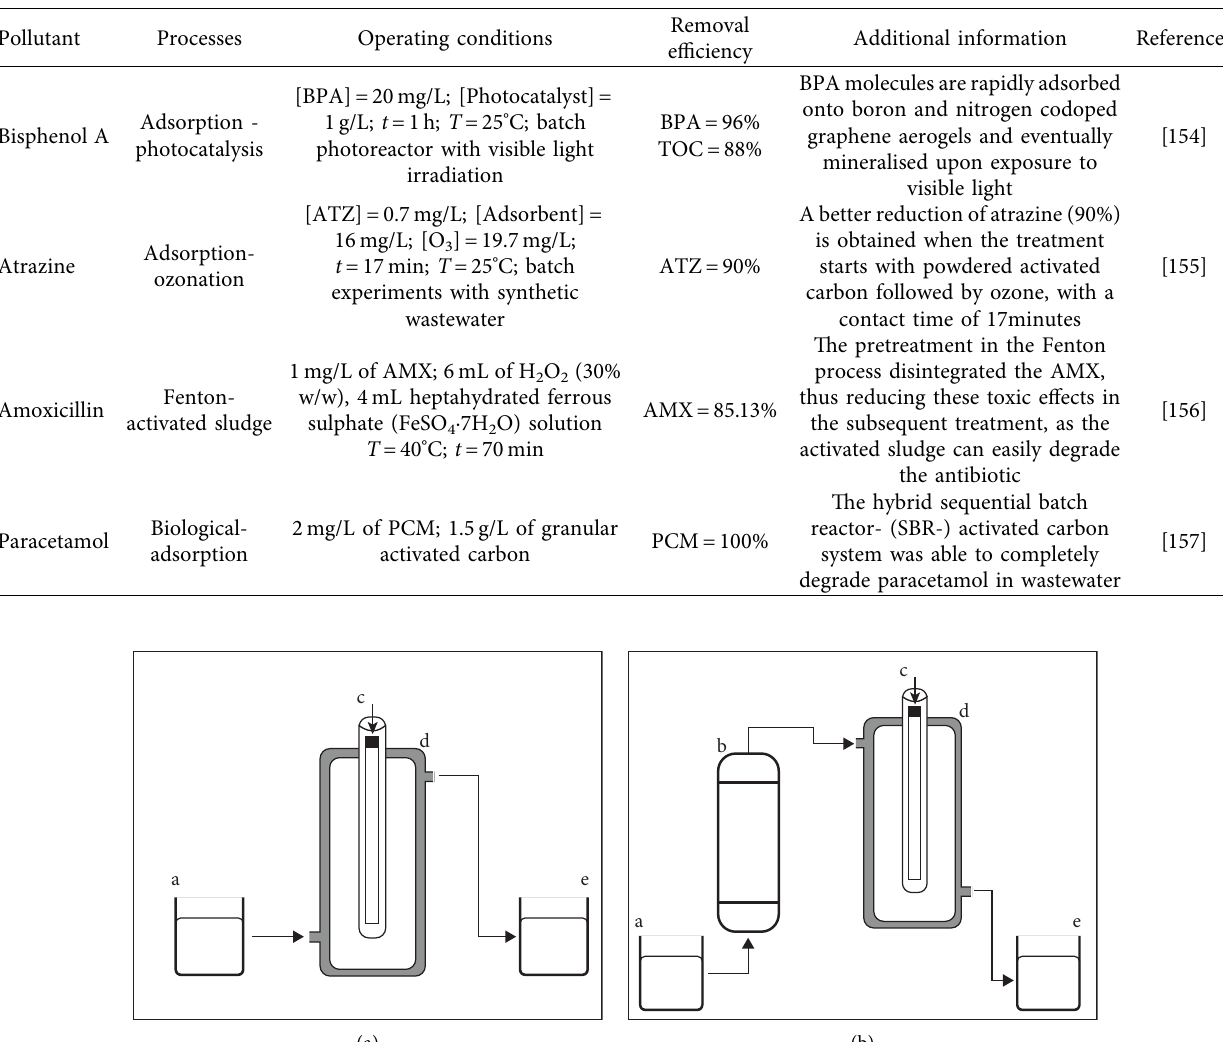
Table 6: Removal of emerging pollutants by hybrid processes.